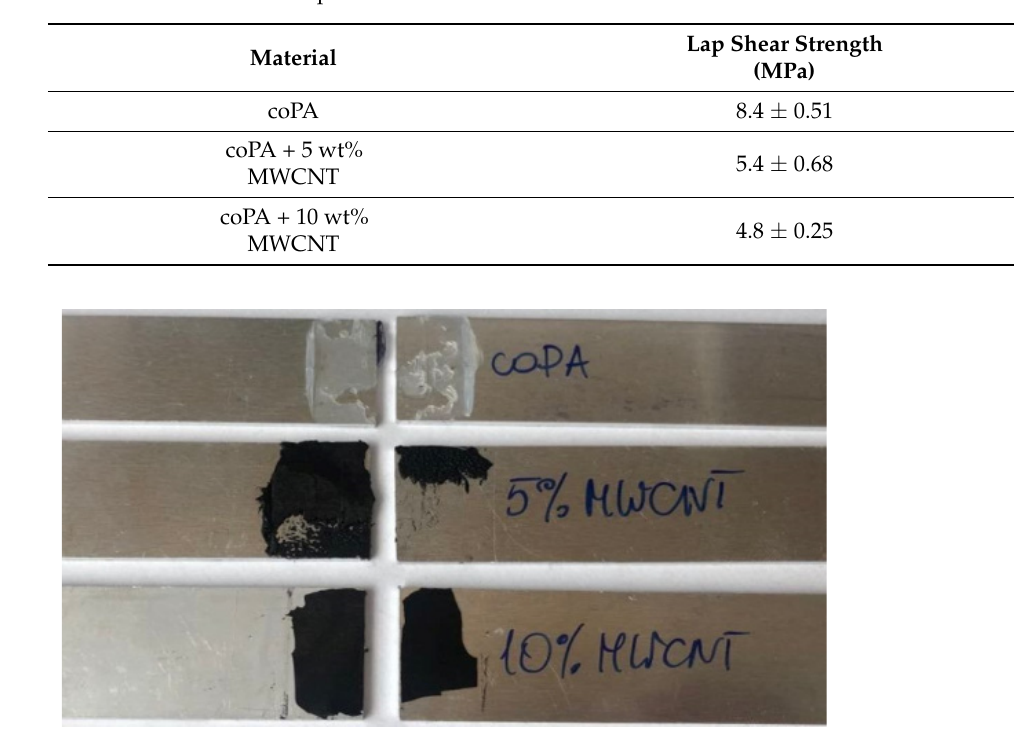
Figure 10. Fracture pattern of joints bonded with MWCNTs modified hot melt at different concen- trations.